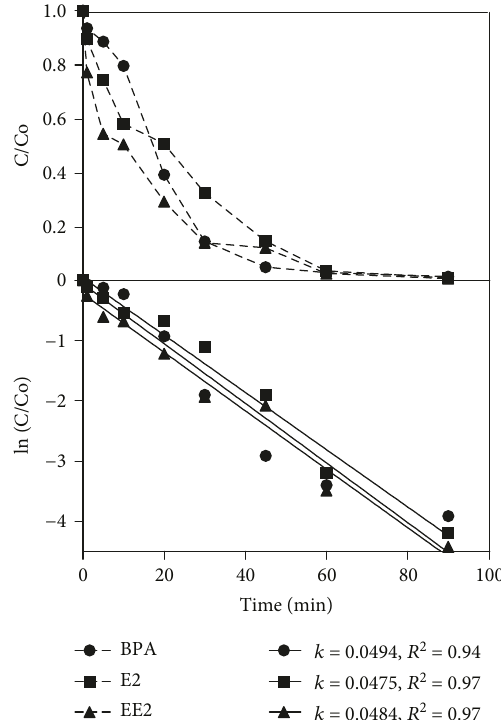
Figure 3: EDC photodegradation and respective pseudo- fi rst- order rate constants (minutes) in WWTP by Cl/UVC. Initial EDC concentrations: 100 μ g · L -1 , initial chlorine concentration = 2 mg · L -1 , UVC irradiance = 14.79 mW cm -2 , T = 25 ° C, pH = 7, reaction time: 90